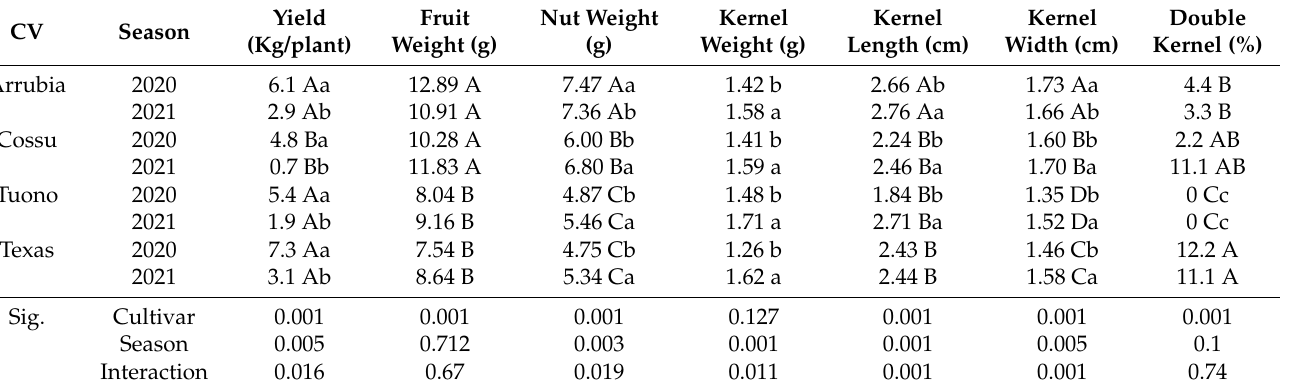
Table 4. Fruit yield and yield compounds during the study seasons. Values are the mean ± standard error and two-way ANOVA of cultivar, season, and interaction effects. Different capital letters indicate significant differences among cultivar and different lowercase letters indicate significant differences among